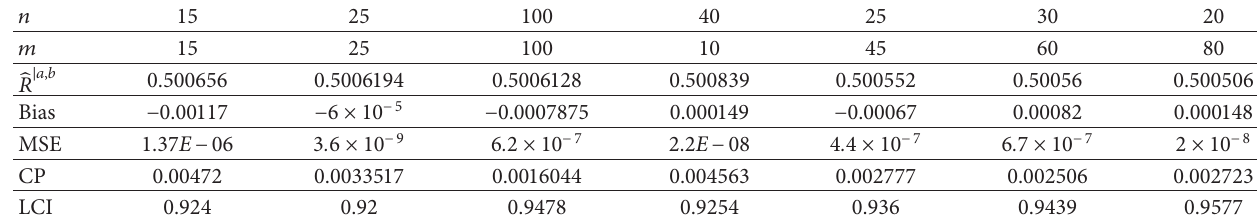
Table 1: Results for R | 2 , 2 � 0 . 50061 and some values of sample sizes n and m .